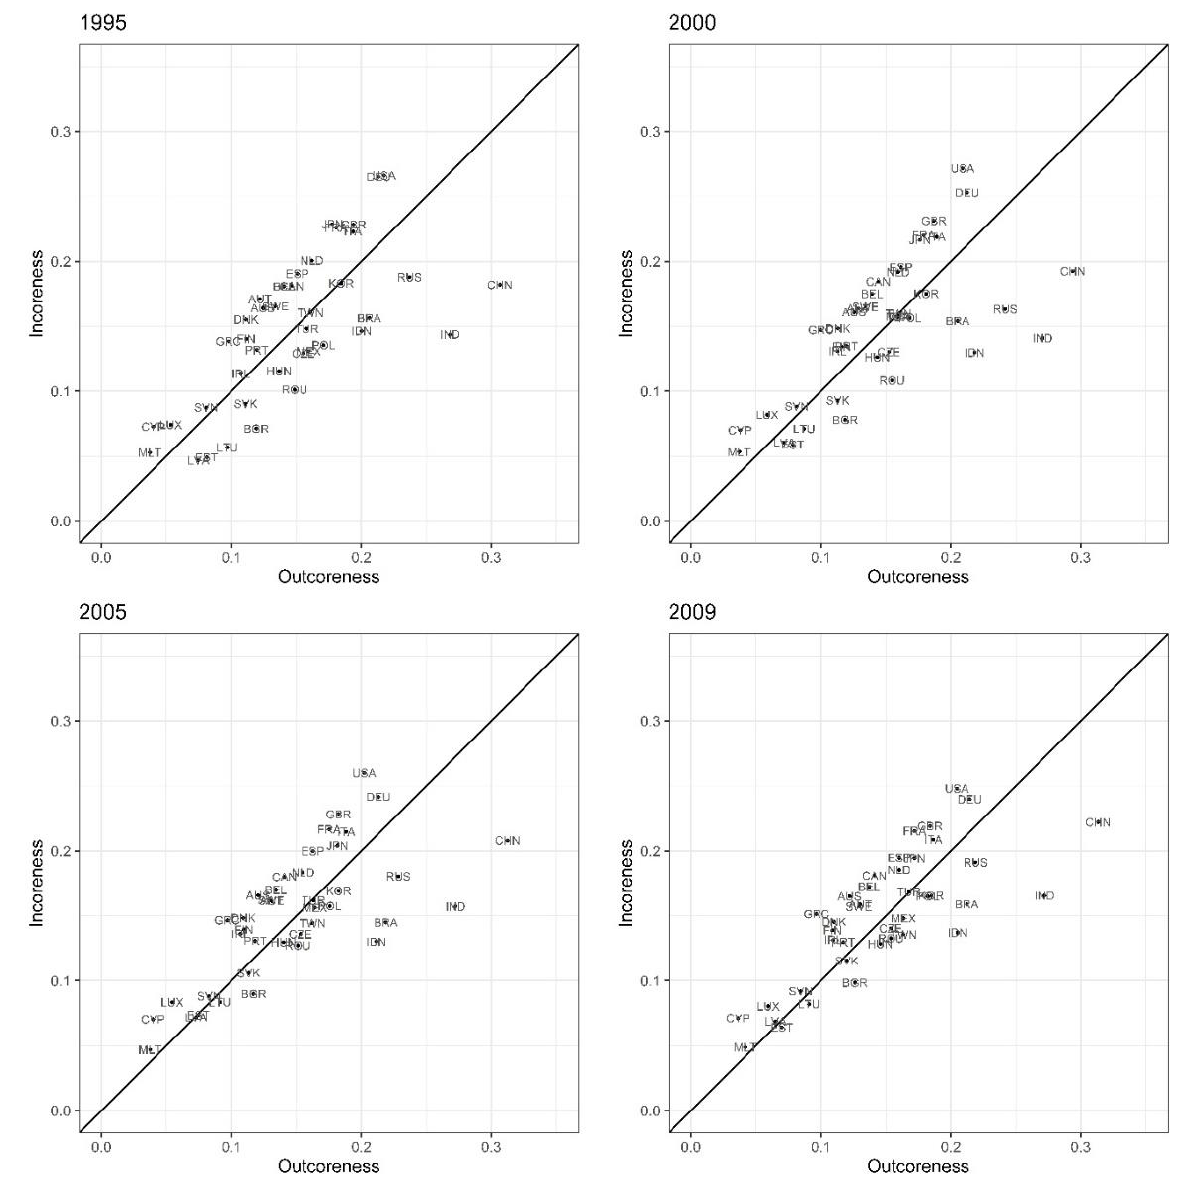
Figure 3. The evolution of the network structure of international labor time flows in the u - v space,